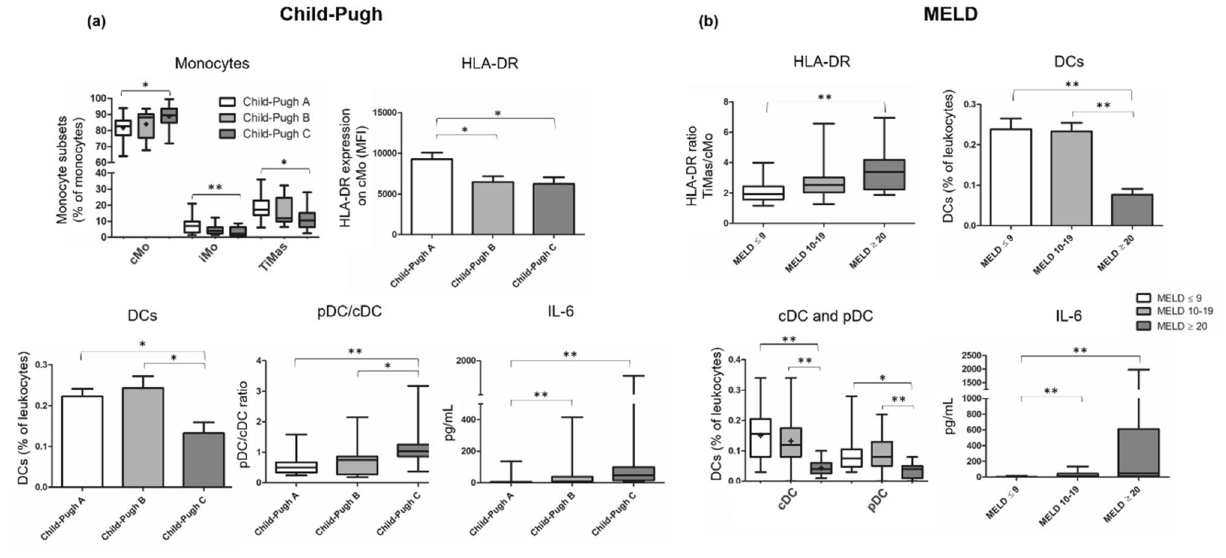
Figure 4. Monocytes, DCs and IL-6 in cirrhotic patients classifed according to Child–Pugh and MELD scores. A series of comparisons of relative numbers of monocytes and DCs and plasma levels of IL-6 of cirrhotic patients classified as Child–Pugh A, B or C (Panel a), and as MELD ≤ 9, 10–19 or ≥ 20 (Panel b). * p ≤ 0.05; ** p ≤ 0.01. Differences were tested using Kruskal–Wallis or ANOVA/Bonferroni. Parametric variables are represented by boxplot with a “ + ” (mean) or by column